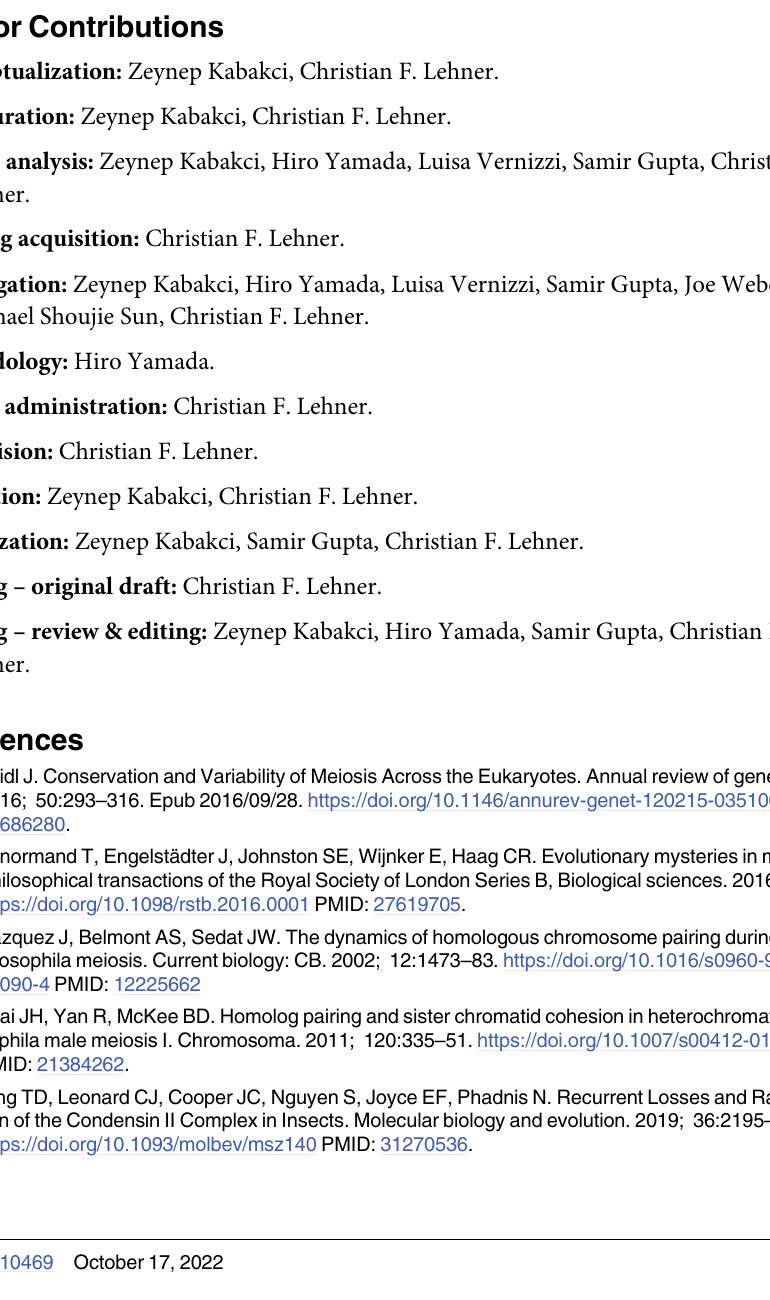
S2 Table. Description of the analyzed genotypes. S3 Table. Synthetic DNA fragments. S4 Table. Source